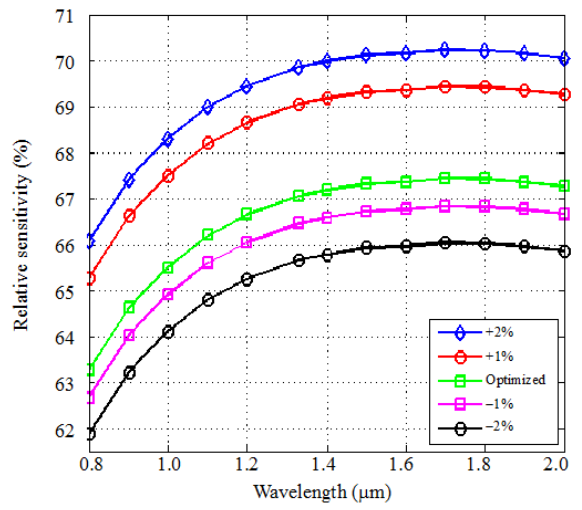
Fig. 9 Comparison of relative sensitivity with optimum structural parameters variations for n =